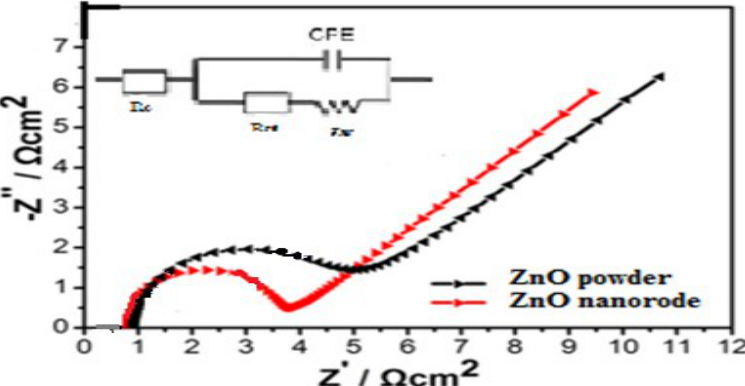
10 Figure 11. Cycle life comparison of ZnO nanorods vs. ZnO micro powder at charge/dis- charge 0.1C and 0.5 C. 3.3.4. Electrochemical Impedance Spectroscopy (EIS) The better cyclic performance of ZnO nanorods compared with that of ZnO powder electrodes is credited to its lower resistance. Electrochemical impedance spectroscopy (EIS) measurements were collected in the frequency region between 0.01 Hz and 100 kHz with a 5 mV amplitude voltage (Autolab Potentiostat 30) at an open circuit voltage of 1.55 V. Figure 12 shows the Nyquist plots of ZnO powder and ZnO nanorods anode and equiv- alent circuit. According to the literature [16], R e represents the total resistance of the elec- trolyte, electrode and separator. R f and CPE 1 are related to the diffusion resistance of Zn 2+ ions through the solid electrolyte interface (SEI) layer and the corresponding constant phase element (CPE). R ct and CPE 2 correspond to the charge transfer resistance and the corresponding CPE. Zw is related to the solid-state diffusion of Zn 2+ ions in the active materials corresponding to the sloping line at the low frequency (so-called Zw is the War-